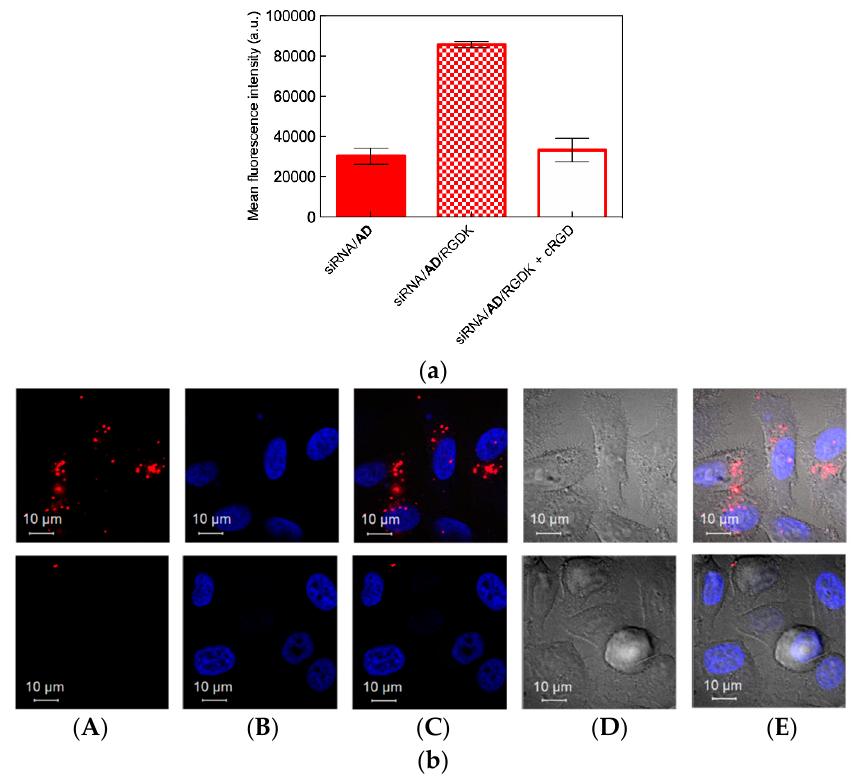
Figure 15. ( a ) Flow cytometry analysis of cellular uptake of siRNA/ AD and siRNA/ AD /E 16 G 6 RGDK nanoparticles in PC-3 cells using a siRNA labeled with the fluorescent Cy5 die. The last column shows the cell uptake results for the siRNA/ AD /E 16 G 6 RGDK obtained in the presence of the cyclic peptide c-RGD, an ανβ 3 -integrin integrin binder. ( b ) Cellular uptake visualized by confocal microscopy of the siRNA/ AD /E 16 G 6 RGDK complexes in the absence (top panel) and in the presence (bottom panel) of a Nrp-1 antibody. Images from left to right: ( A ) cy5-labelled siRNA; ( B ) nucleus (4 ′ ,6-diamidino-2-phenylindole (DAPI) staining); ( C ) merged ( A , B ). The last two images ( D , E ) are the bright field version of ( B , C ). In all these experiments, the siRNA/ AD /E 16 G 6 RGDK nanoassemblies were prepared using 50 nM siRNA, siRNA/ AD N/P = 10, and AD /E 16 G 6 RGDK molar ratio = 5. Adapted from [8] with permission of the American Chemical Society, 2018.